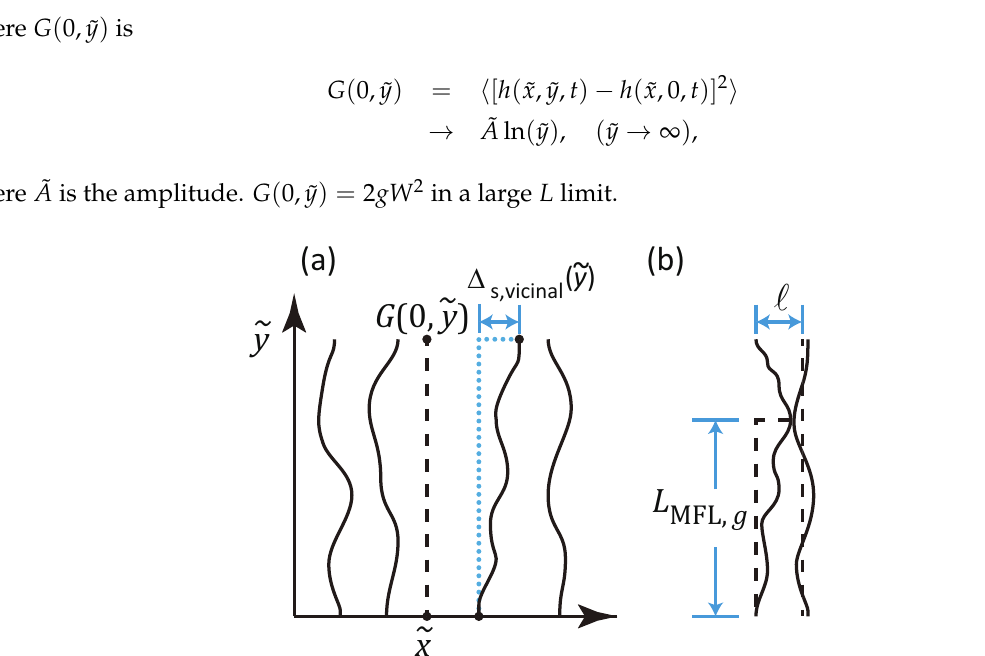
Figure 12. Schematic illustrations of step width based on a top-down view of a vicinal surface. ( a ) Relationship between surface height–height correlation G ( ˜ x , ˜ y ) and the step width ∆ s ,vicinal ( ˜ y )) on a vicinal surface. ( b ) Definition of L MFL, g . (cid:96) = L / N step is the mean step